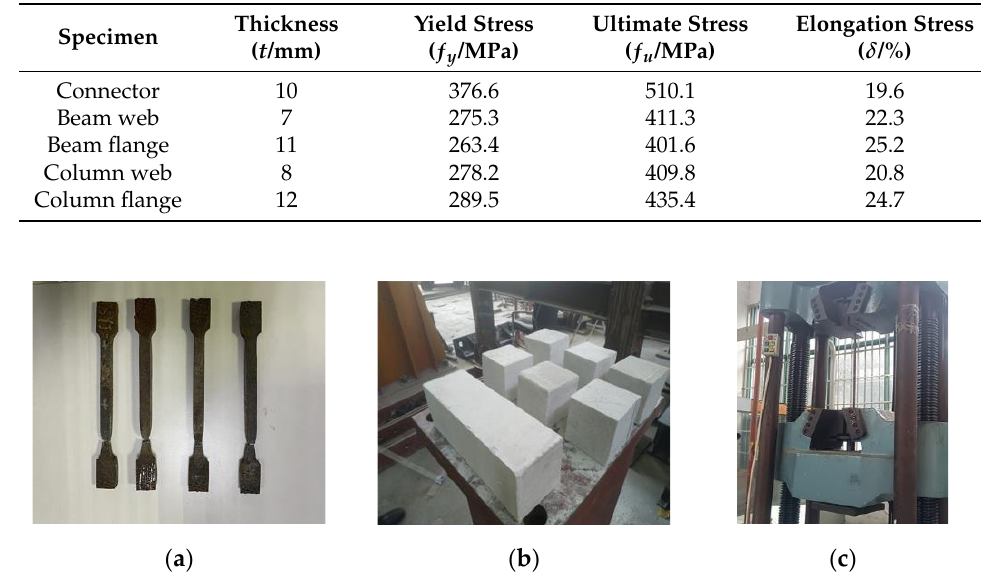
Table 1. Material performance test results.